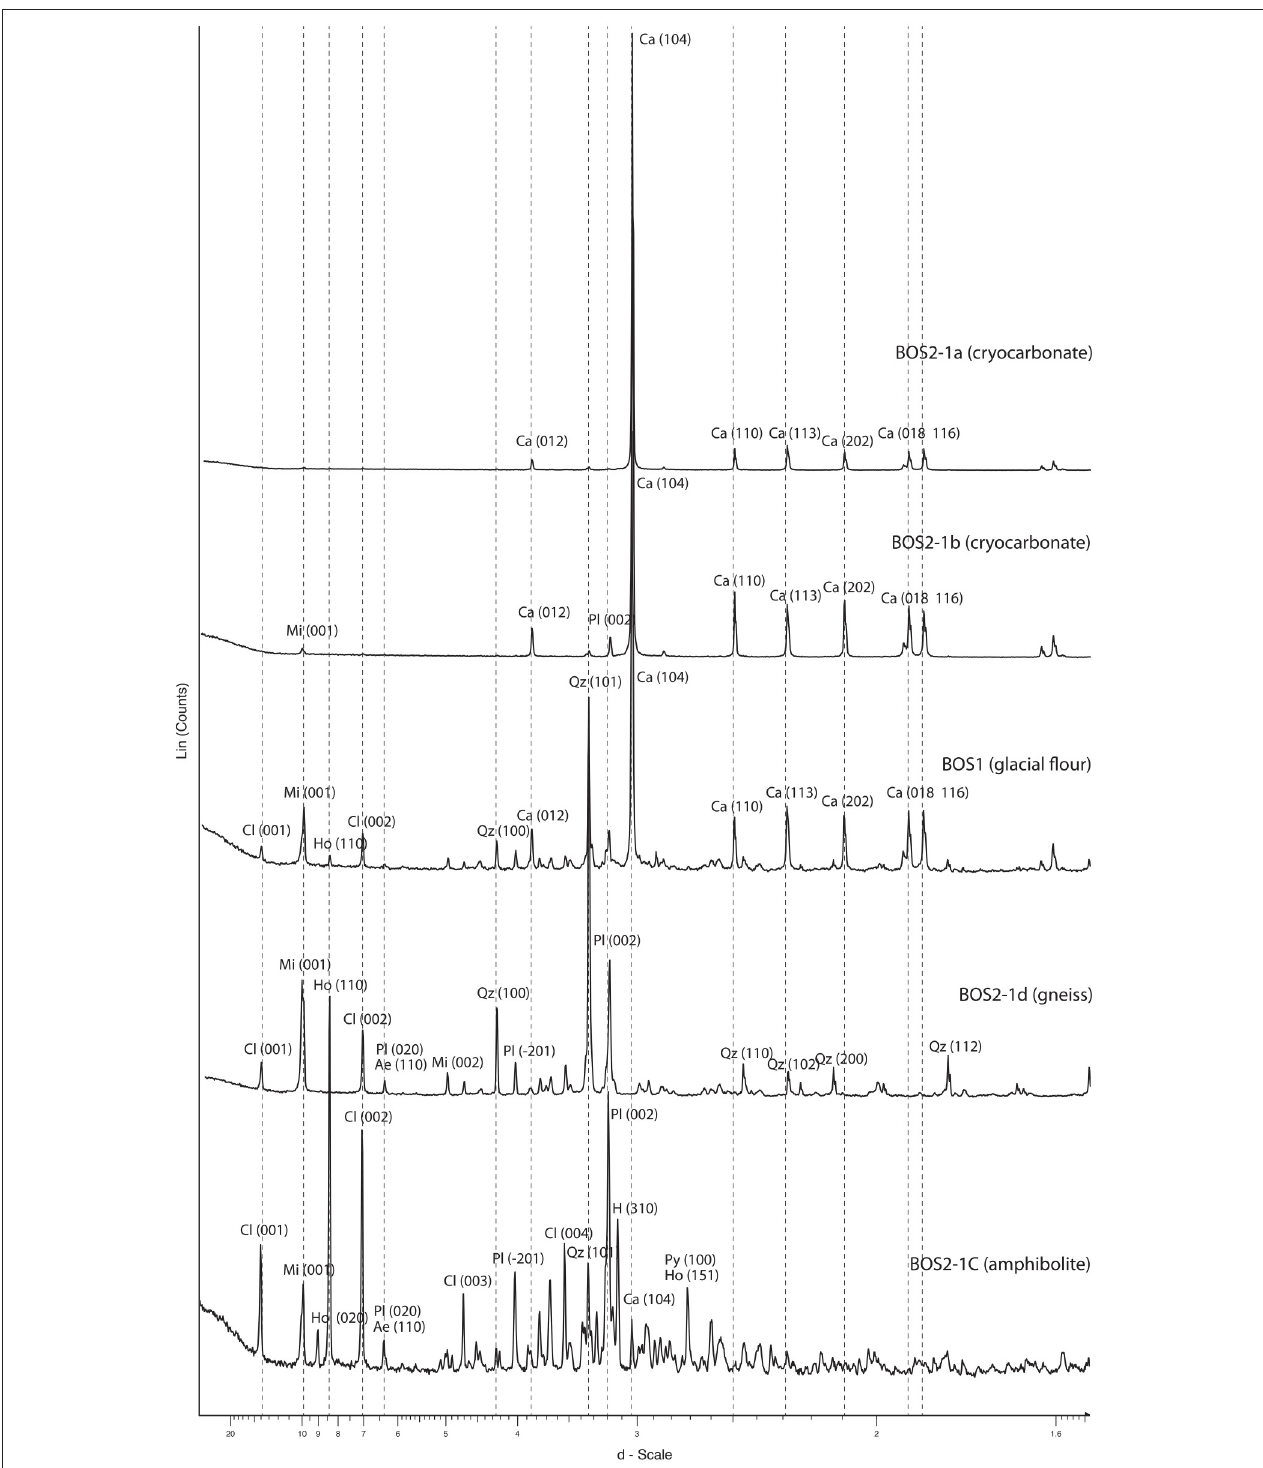
FIGURE 6 | XRD diagrams reflecting the bulk composition of cryocarbonate and bedrock samples. All diagrams are corrected using the (100) diffraction peak of quartz (4.257 Å) or (104) the diffraction peak of calcite (3.035 Å). Abscissa, expressed in angstrom (Å), represent an interatomic separation of the crystalline sheets; ordinate, expressed as counts of X photons, represents the intensity. The mineralogical phases associated with peaks are labeled (Ae, aegyrine; Ca, calcite; Cl, Chlorite; Ho, Hornblende; Mi, micas Pl, plagioclase; Py, pyrite; Qz, quartz) as well as the nature of the crystalline sheets (Miller index in brackets). The intensity of the main diffraction peaks is proportional to the mineralogical phase